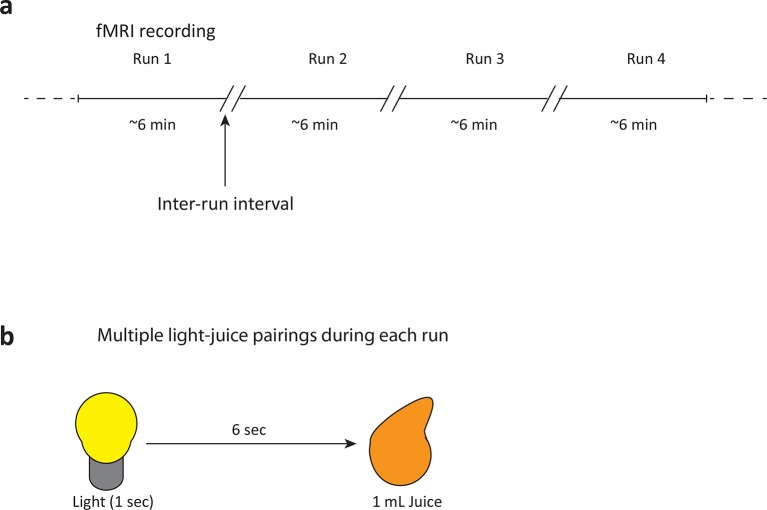
fMRI recording paradigm and reward-stimulus pairing in human smokers.(a) The fMRI recording session consisted of four 5–7 min blocks of light-juice pairings. A self-paced break (“inter-run interval”) was included between runs to allow participants to ask any questions and to allow the investigators to provide feedback on participant motion within the scanner. (b) A total of fifty-five light-juice (1 mL) pairings were presented. The delay between light and juice was 7 s.